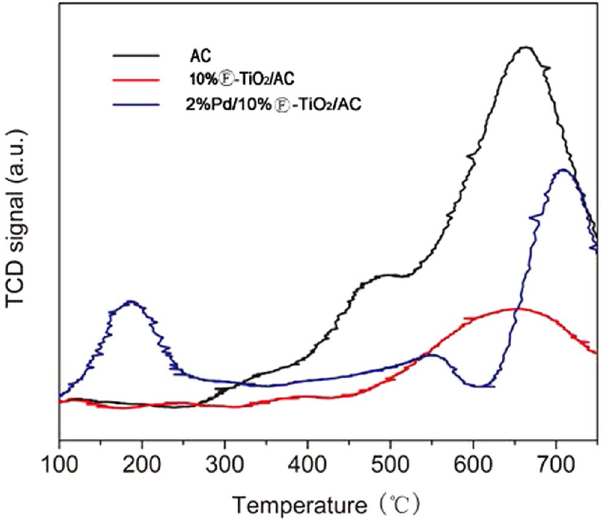
Figure 4. The H 2 -TPR profiles of AC, 10% Ⓕ -TiO 2 /AC and 2%Pd/10% Ⓕ -TiO 2 /AC.